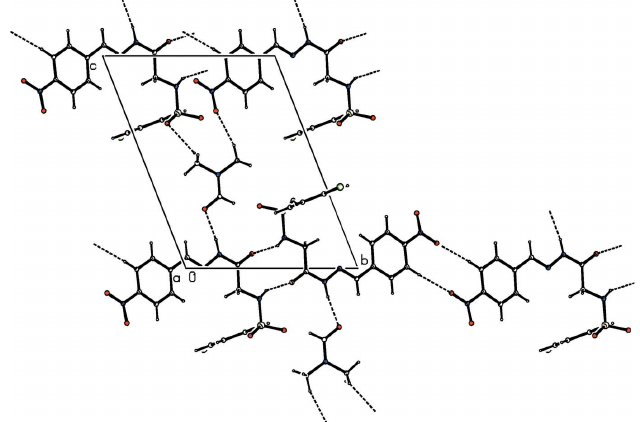
Figure 3 The molecular packing of the title compound, with hydrogen bonding shown as dashed